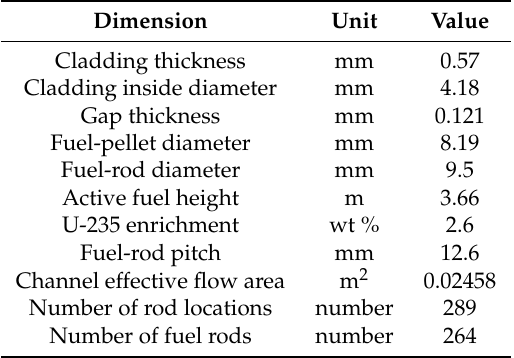
Table 1. Fuel and cladding properties for a typical four-loop Pressurized Water Reactor